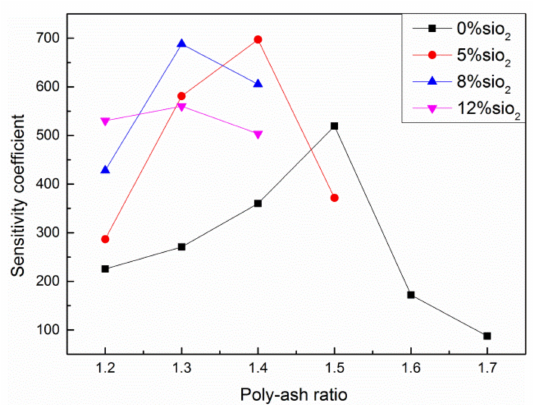
Figure 7. Relationship curve for sensitivity coefficient of variation and poly-ash ratio in CNFPUC